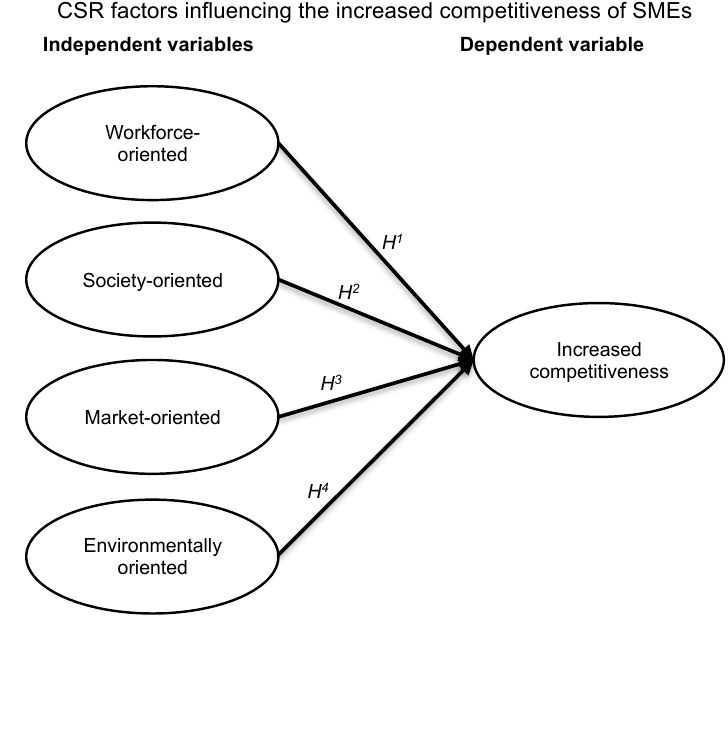
CSR factors influencing the increased competitiveness of SMEs Independent variables Dependent variable